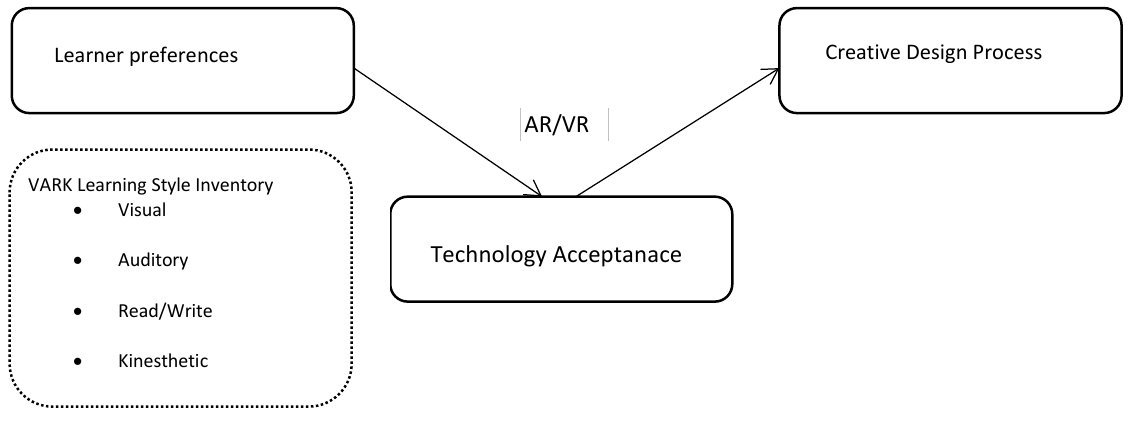
Figure 1. Effect of learner preferences on using AR and VR in the creative design